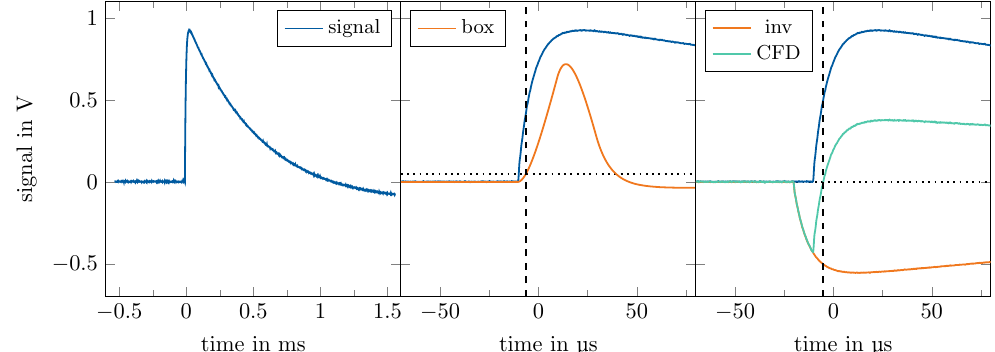
Figure 1. Illustrationof the k σ and CFD filter algorithms. Horizontal dashed lines represent threshold levels that the filtered signal is required to cross in order to initiate a trigger. Vertical dashed lines indicate the resulting arrival time of the pulse. Left: Entire raw detector signal as recorded by the data acquisition system ( t = 0 defined by the hardware trigger). Blue line in all plots: raw signal. The middle and right plots focus on the signal’s rising slope. Centre: Illustration of the k σ trigger applied to the box-filtered signal (orange; see text for details). The threshold is set as a k -multiple of standard deviation σ of the filtered signal trace ( k is drastically exaggerated for illustrative purposes). Right: The CFD signal (green) is the sum of the raw signal (blue) and a scaled, delayed, and inverted copy of the raw signal